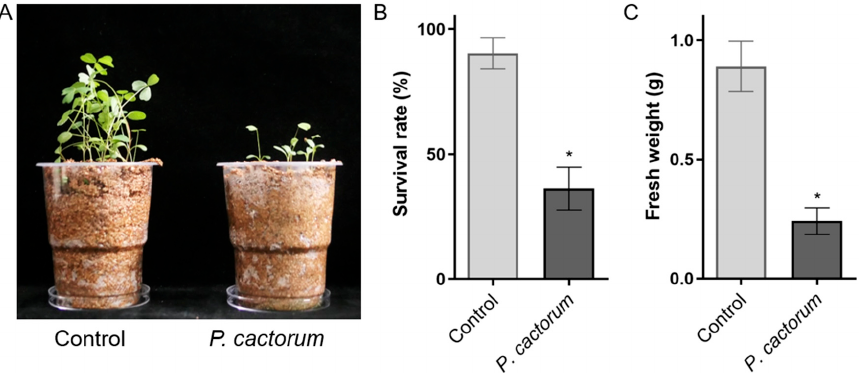
of six independent experiments and error bars represent SD. Asterisks at the top of the bars indicate statistical significance (T-test, p < 0.05).